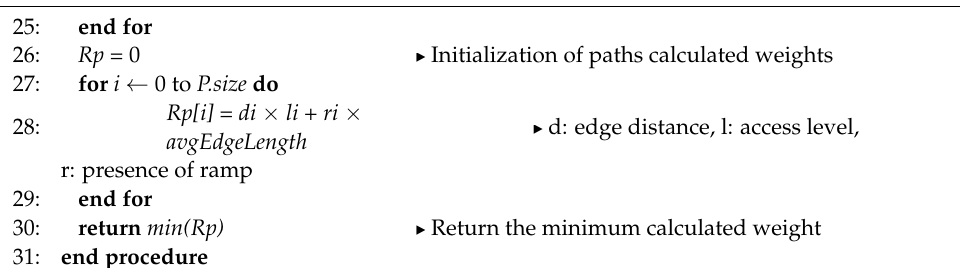
Algorithm 1 The Proposed Algorithm procedure PROPOSED-ALGORITHM